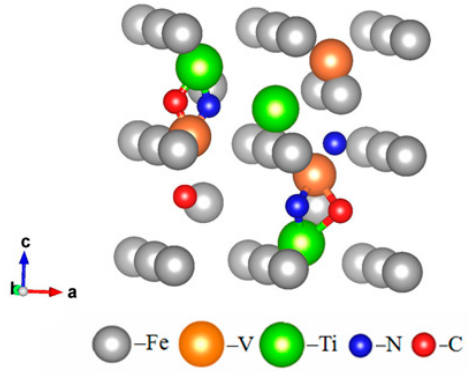
Figure 1. Atomic model of the Fe–V–Ti–N–C system coupling precipitation.